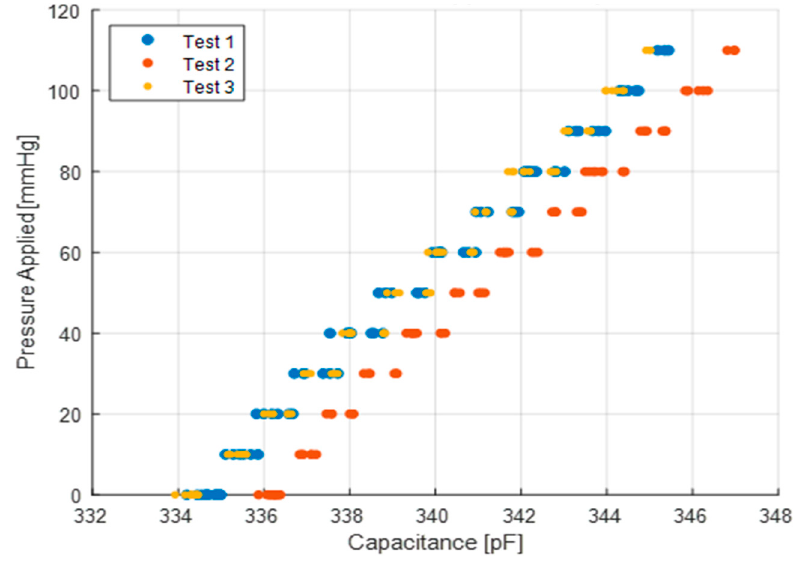
Figure 10. Sensor capacitance at various applied pressures–bladder test results.